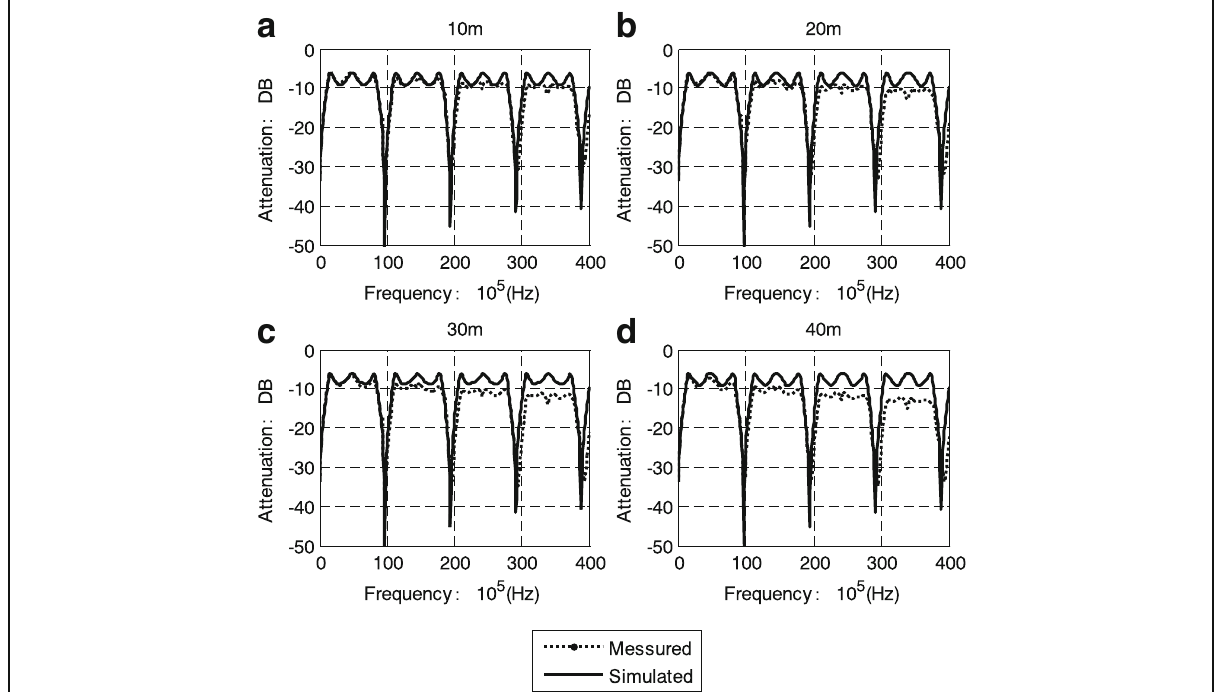
Fig. 17 Voltage transmission amplitude-frequency characteristic for various front and rear trunk lengths ( a ) 10m ( b ) 20m ( c ) 30m ( d ) 40m